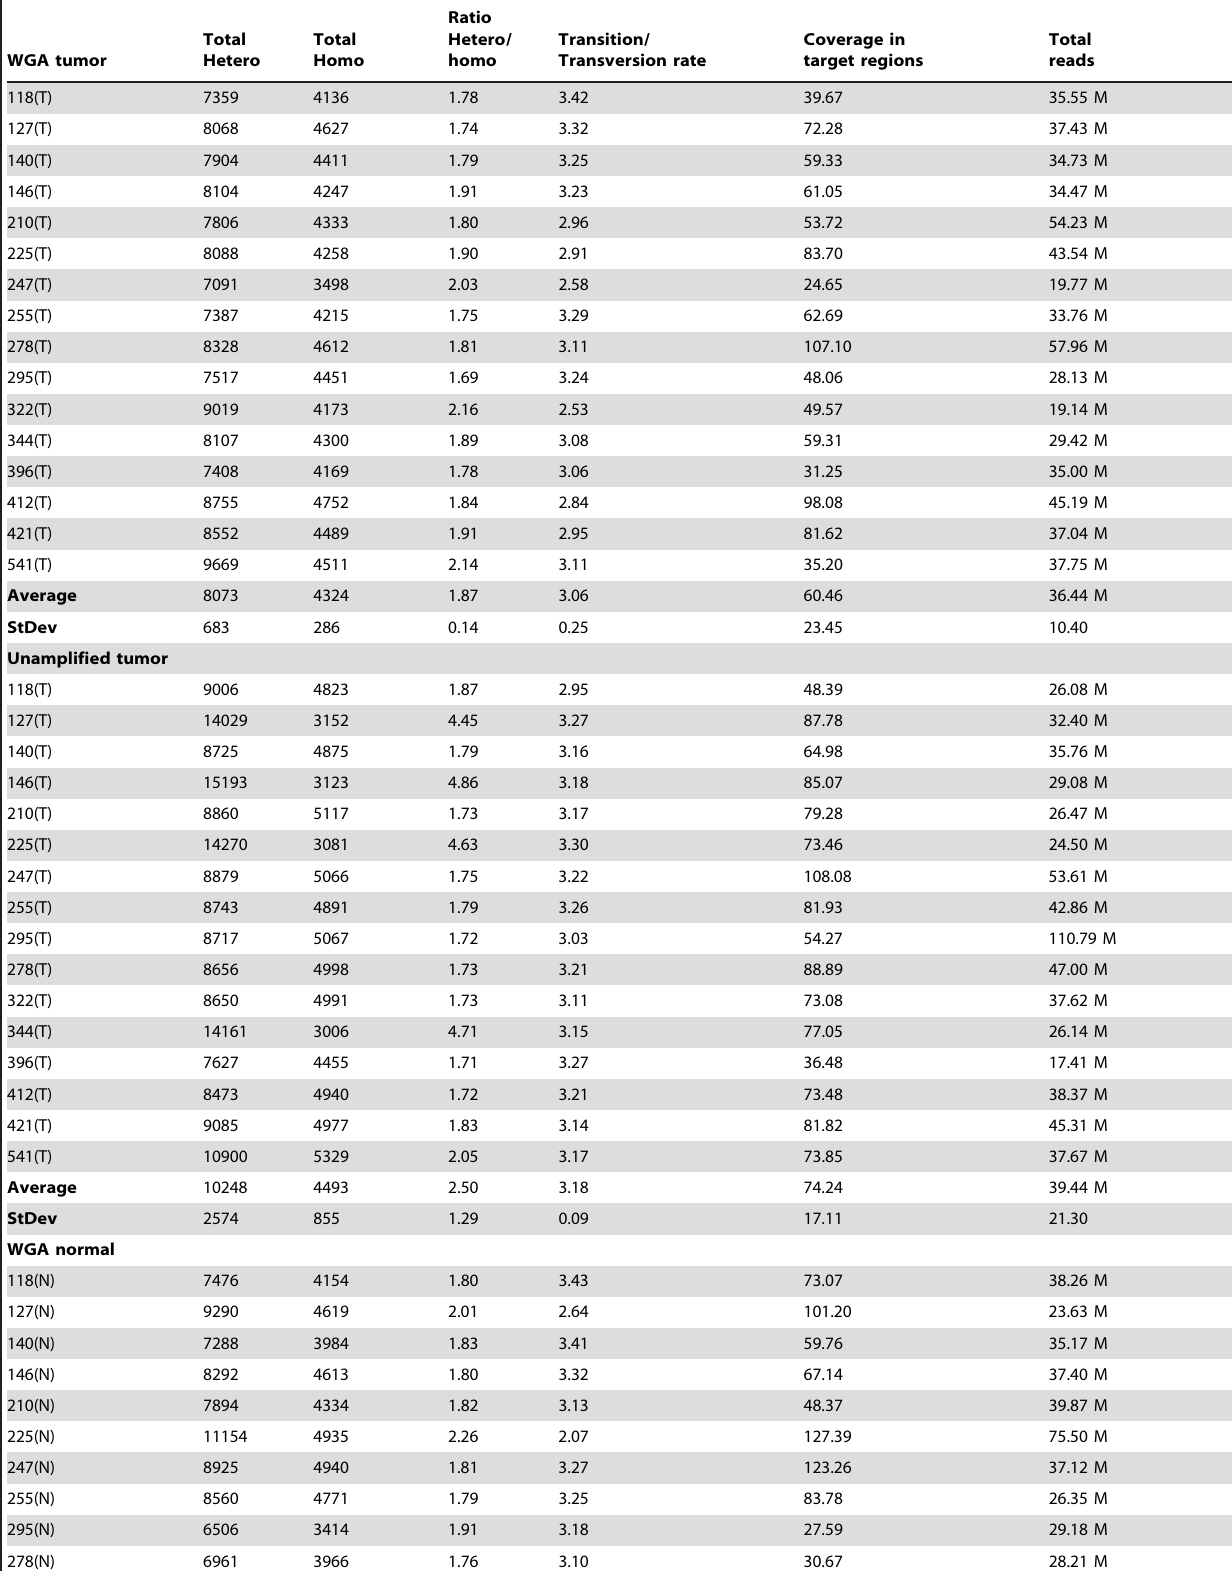
Table 2. Summary of variant calling following DNA sequencing.